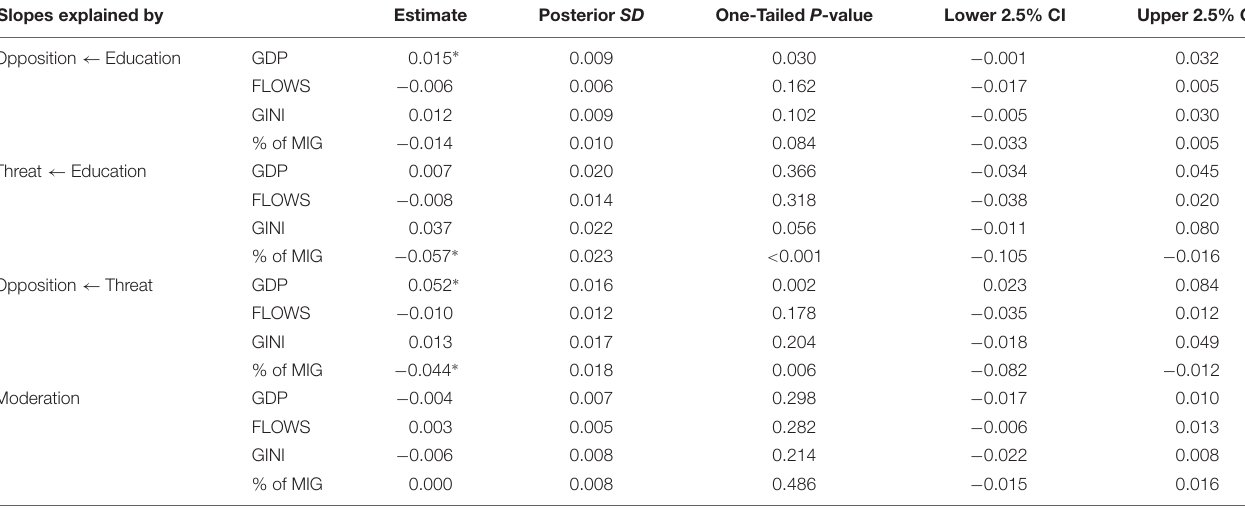
TABLE 7 | Cross-classified mediation-moderation model: factors that explain the variation across countries and survey years in estimated relationships. Slopes explained by Estimate Posterior SD One-Tailed P